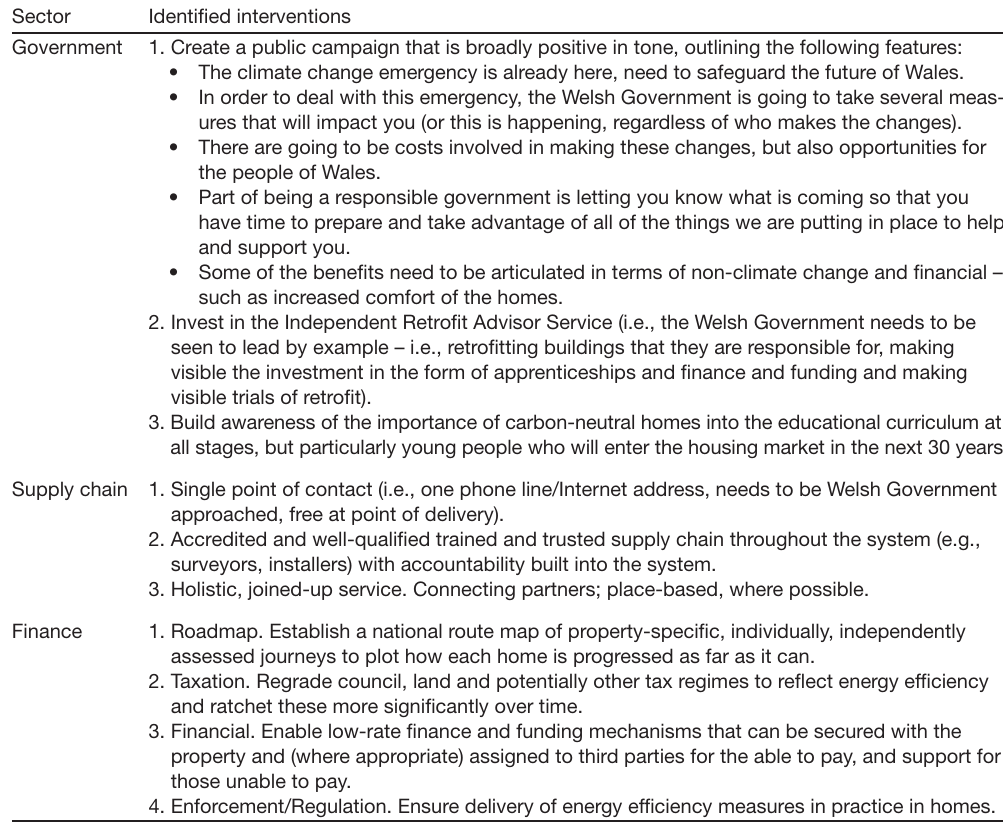
Table 2. Interventions identified by